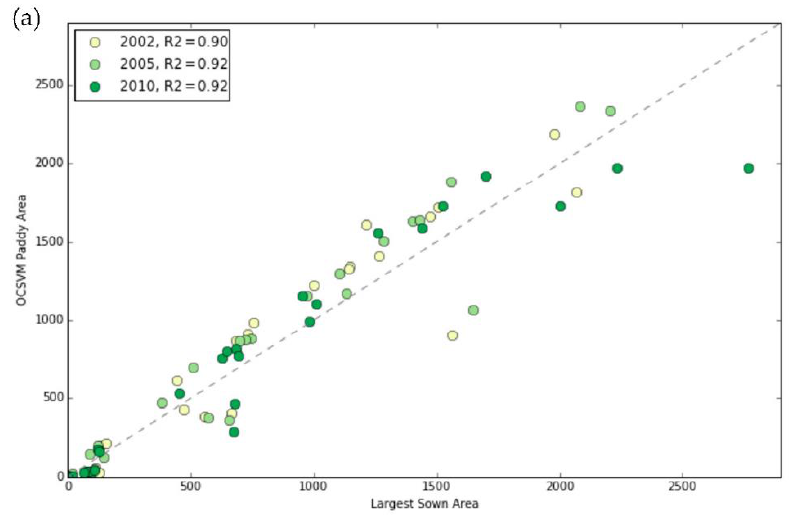
Figure 6. Cont. Figure 6.